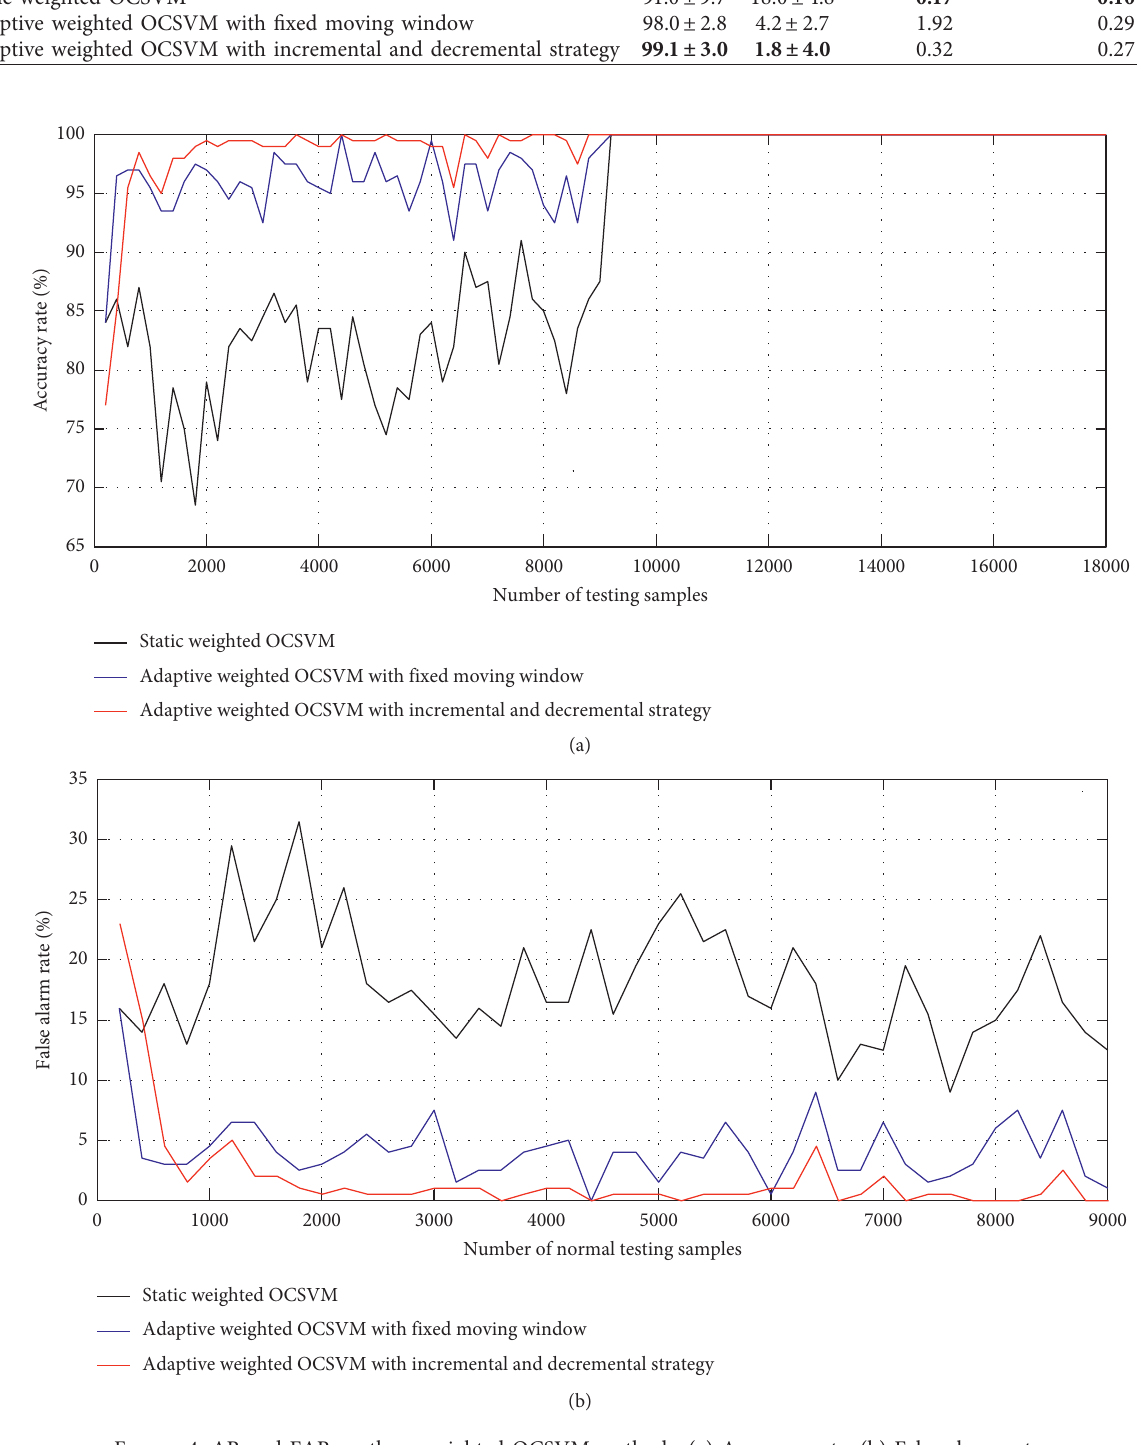
Figure 4: AR and FAR on three weighted OCSVM methods. (a) Accuracy rate. (b) False alarm